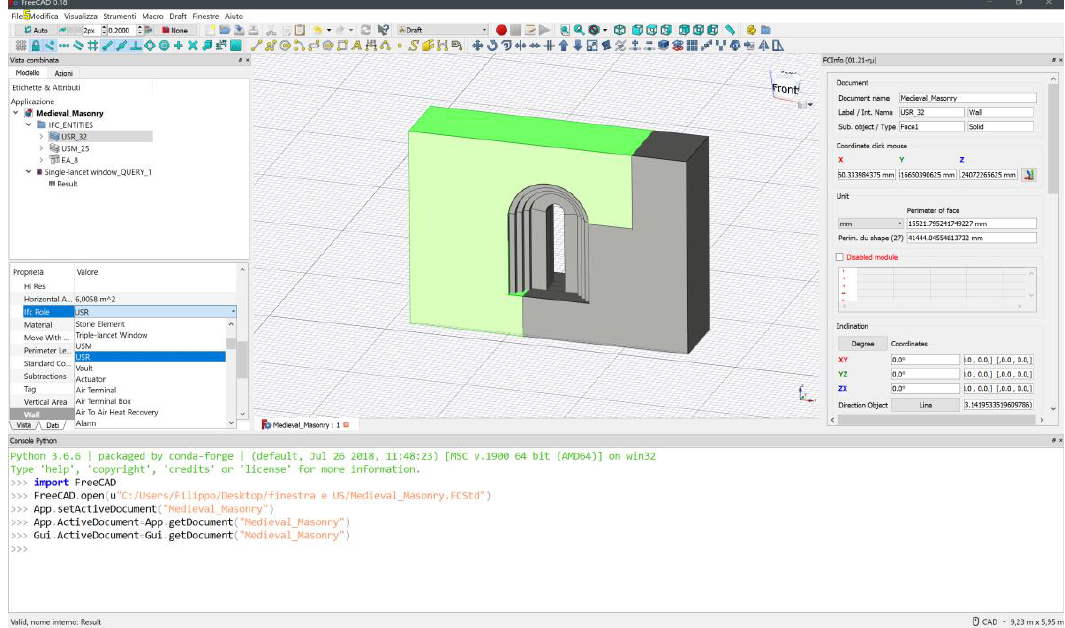
Figure 10. Example of a medieval stone wall: IFC classification of plaster layer on masonry as render stratigraphic unit (USR on the left of single-lancet window — see also Figure 7) available on the drop- down menu after the implementation of ifcWall entity and ArchComponent.py.